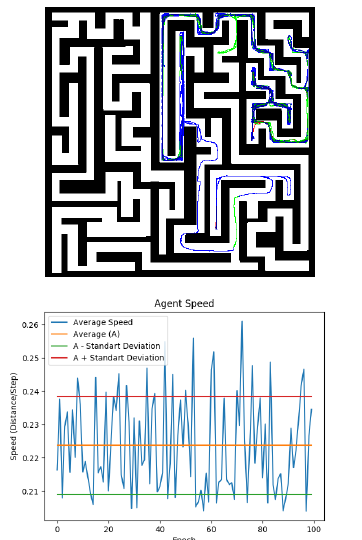
Figure 19. (a) The agent emotional state, and (b) the agent speed with the emotional model’s configurations equal to that shown in line in line 6 of